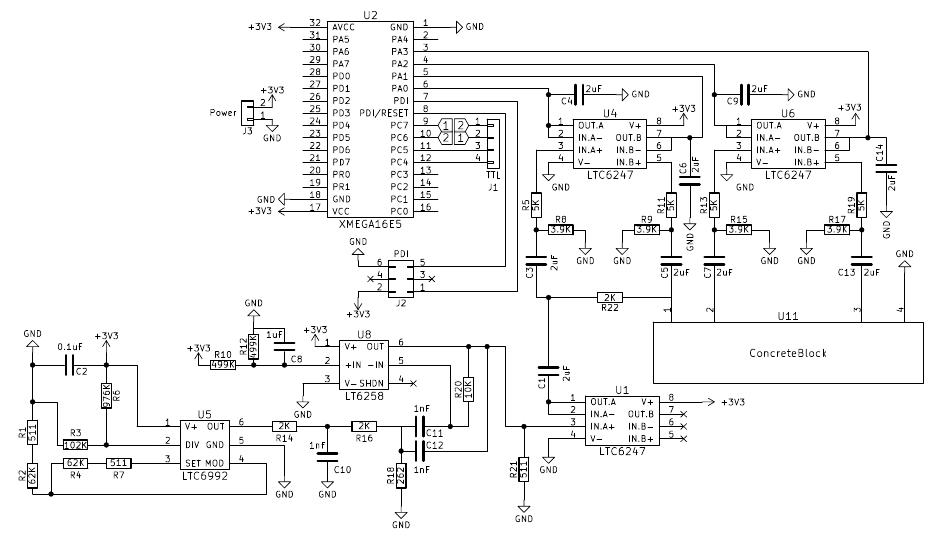
Figure 4. Impedance of concrete. 3. Sensing Device